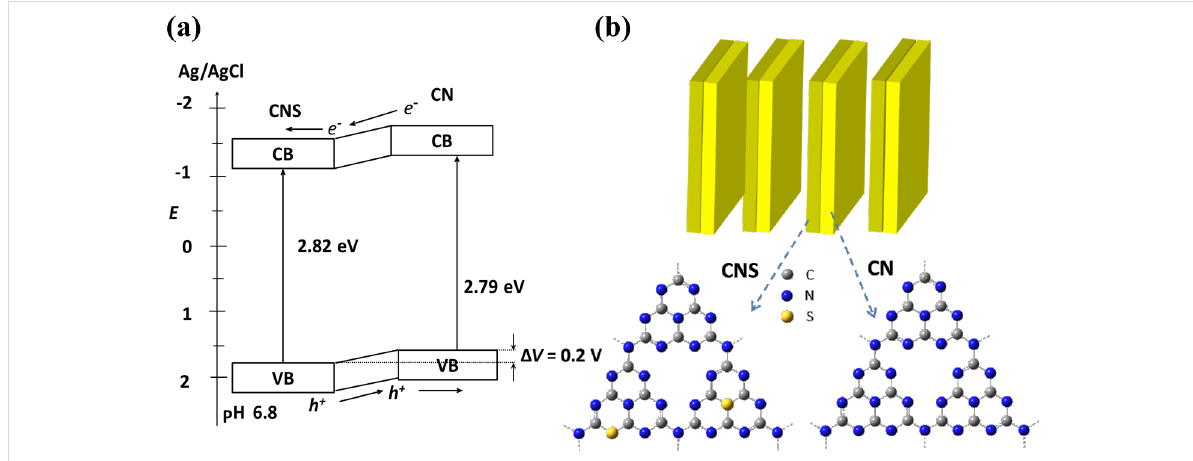
Figure 3: Schematic illustration of (a) electron–hole separation at the CN/CNS heterojunction interface, (b) the structure of CN/CNS heterojunction.